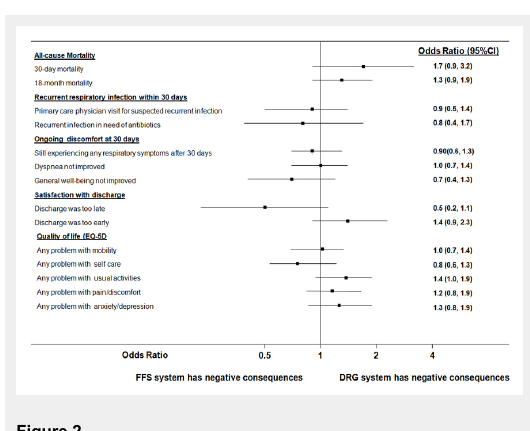
Forest plot showing individual outcomes (separately analysed) according to hospital reimbursement; of note, odds ratios = 0 indicate no effect, while odds ratios >1 indicate a positive association between the exposure variable and hospitals with DRG financing systems; models are adjusted for age, gender, severity (PSI) and comorbidities (congestive heart failure, COPD, chronic renal failure) and account for clustering of patients within